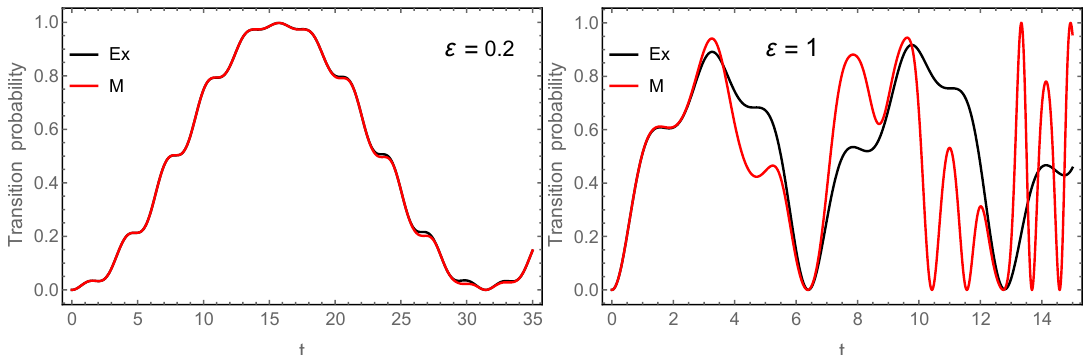
Figure 6. Transition probability obtained with the standard Magnus expansion with n = 3 terms (red line) in comparison with the exact result (black line) for the Bloch–Siegert Hamiltonian with ε = 0.2 (left) and ε = 1